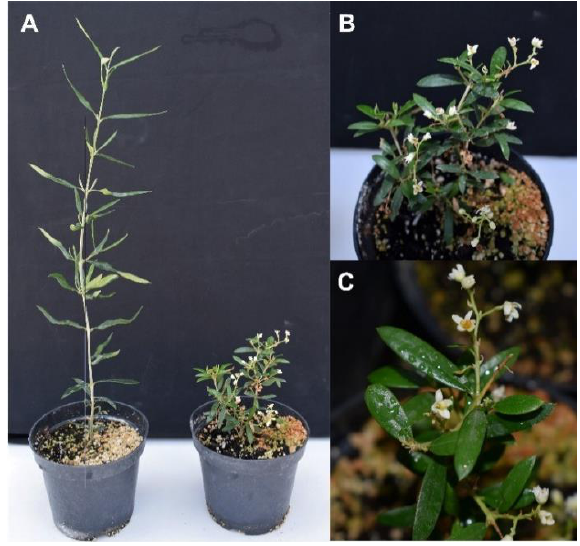
Figure 4. Early flowering olive plants expressing the FT gene MtFTa1 from Medicago truncatula . ( A ) Control (left) and MtFTa1 -transformed (right) olive plants. ( B , C ) Details of MtFTa1 -transformed plants.